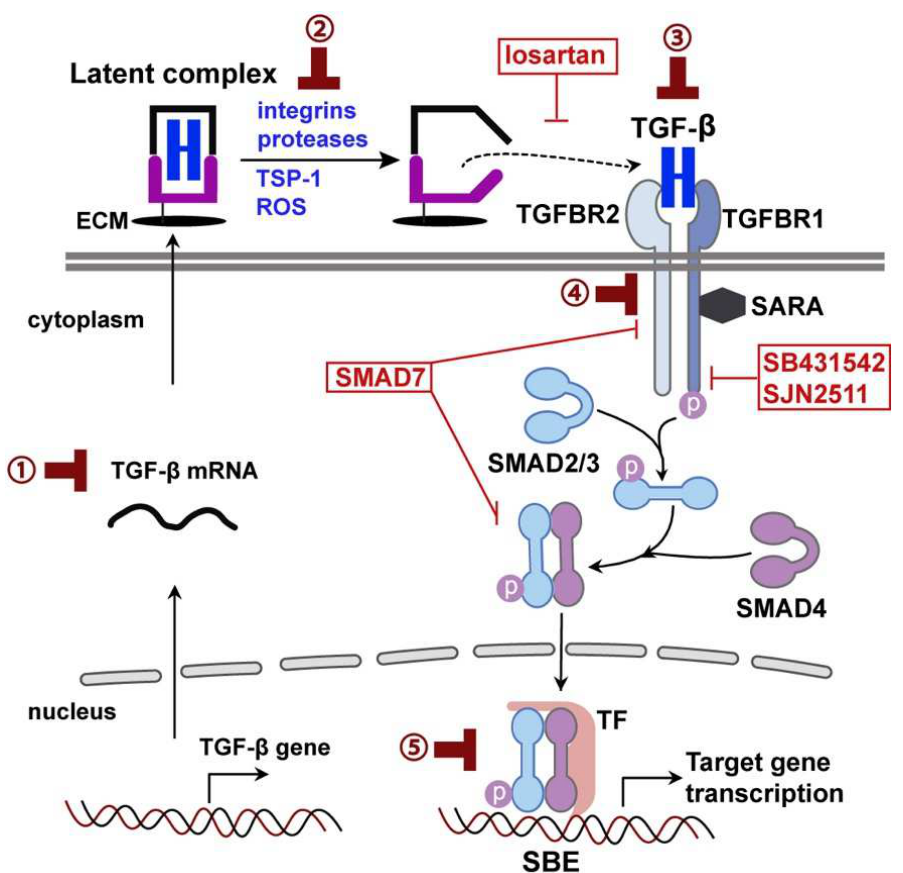
Figure 1. TGF-β activation and the canonical, SMAD-dependent signaling pathway. TGF-β is pro- duced in a latent form as part of a latent complex tethered to ECM. The latent complex consists of mature dimeric TGF-β, associated with latency-associated peptide (black color) and a latent TGF-β- binding protein (magenta color). Latent TGF-β can be activated and released from the complex by integrins, proteases, TSP-1, and ROS. Active TGF-β binds to its receptors and initiates Smad signal- ing to exert its biological effects. The activities of TGF-β signaling can be modulated through (1) TGF-β translation and production, (2) TGF-β activation, (3) TGF-β neutralization using recombinant antibodies, (4) synthetic molecules that inhibit the phosphorylation of the TGFBR and SMAD, and (5) targeting downstream effectors. The red boxes show inhibitors and their action sites mentioned in this review.